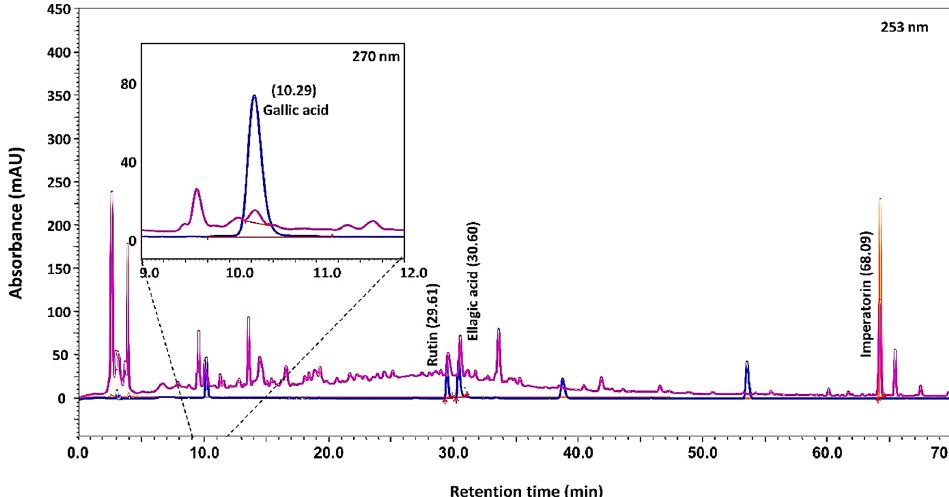
Figure 1. Phytochemical composition of the Cologrit tablet powder. HPLC based analysis showed the presence of Gallic acid (retention time 10.29 min), Rutin (retention time 29.61 min), Ellagic acid (retention time 30.60 min), and Imperatorin (retention time 68.09 min). Table 2 displays phytochemical concentration of tablet.